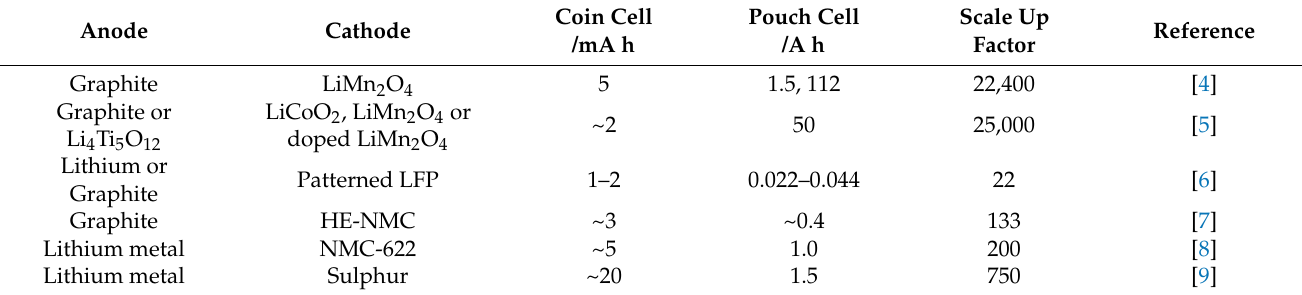
Table 2. Previous scale up tests using different cell